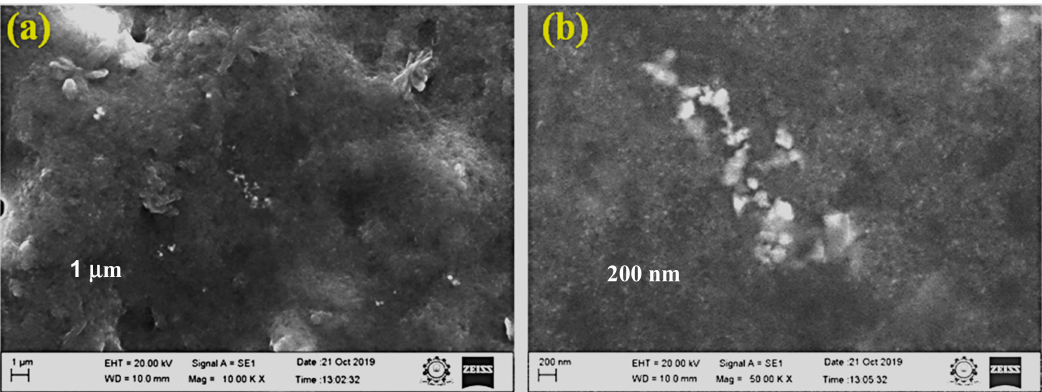
Figure 5. ( a , b ) SEM image of Ag